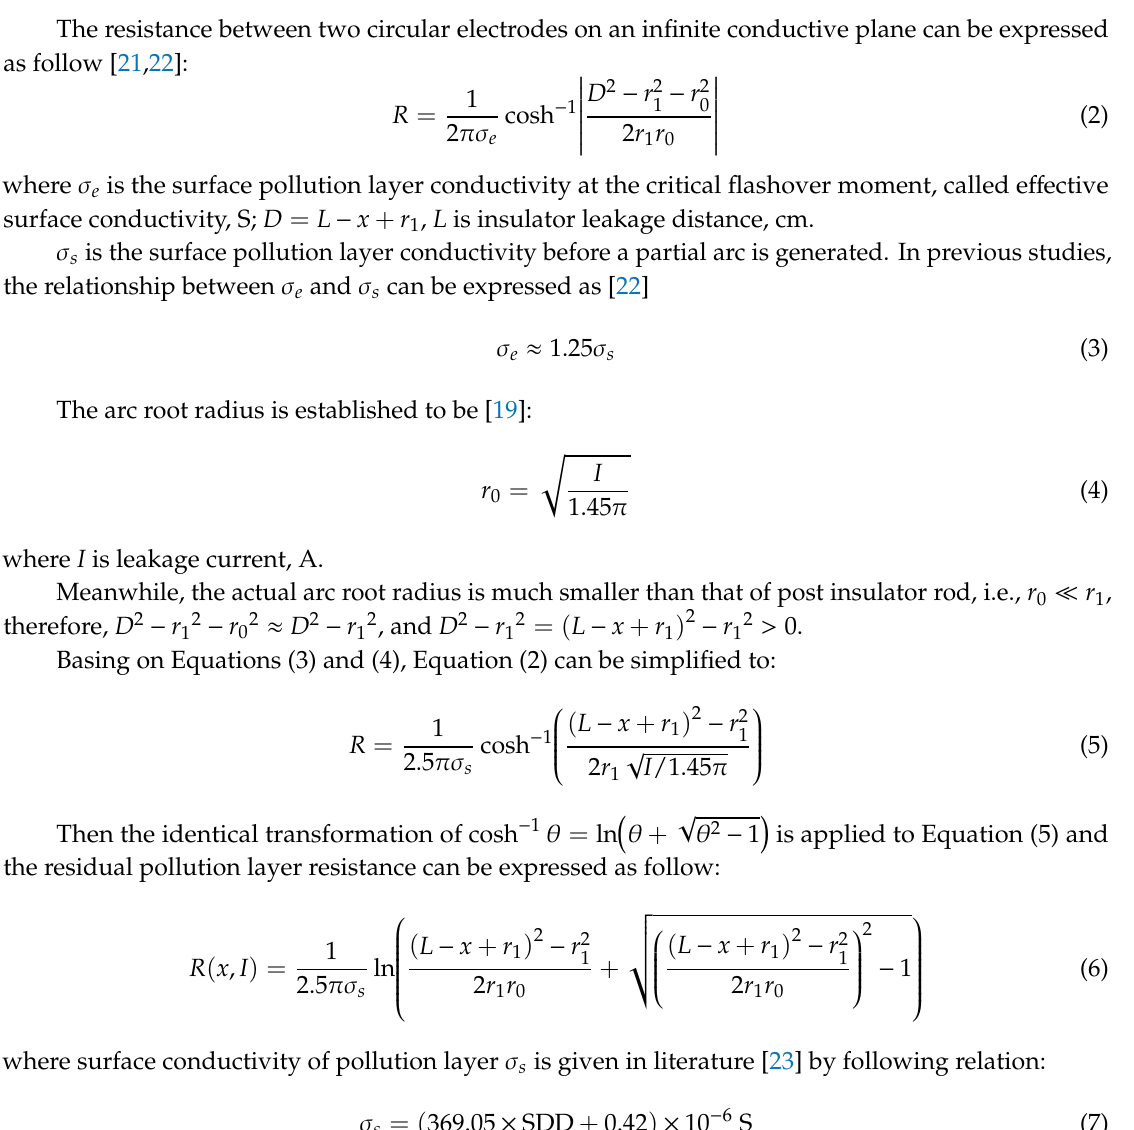
Figure 3. Schematic diagram of residual pollution layer resistance.